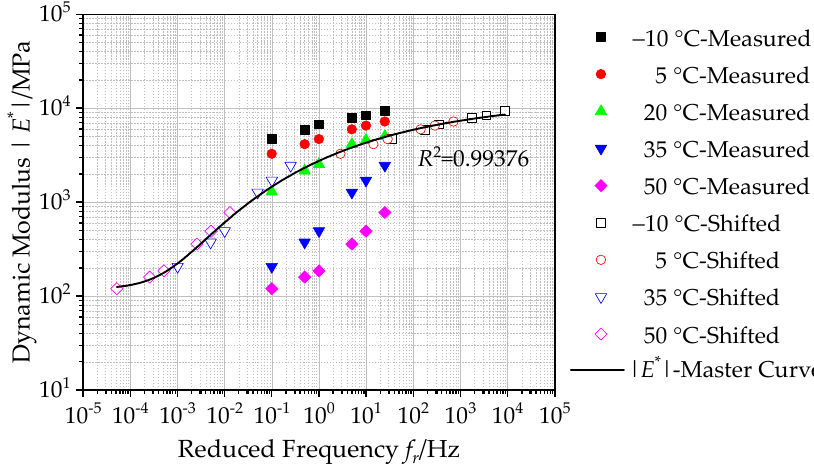
Figure 6. Master curve of dynamic modulus (reference temperature = 20 °C).